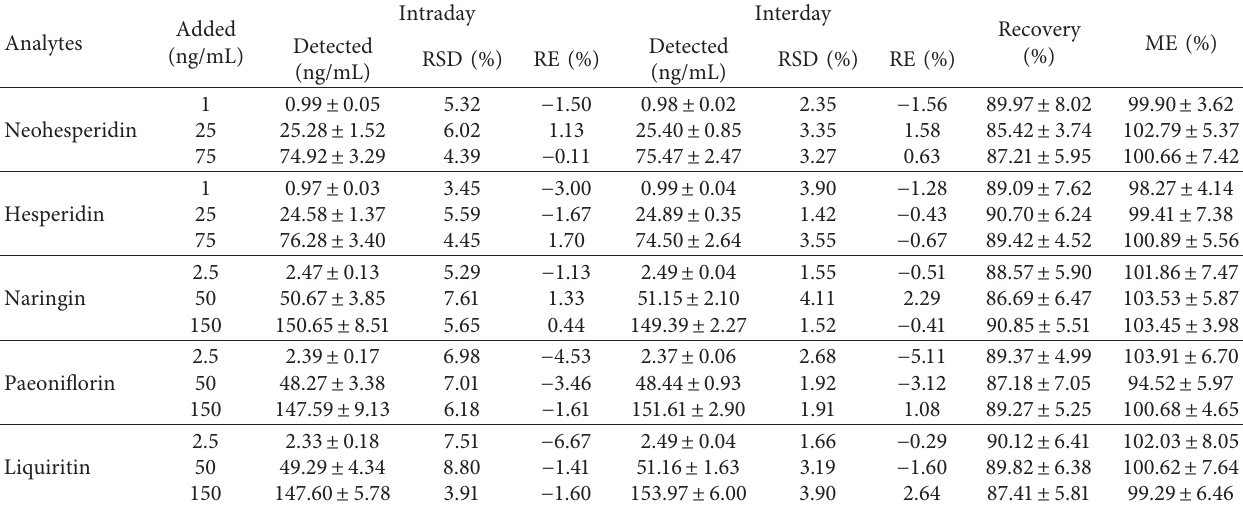
Table 6: The precision, accuracy, recovery, and matrix effects of five analytes in beagle plasma.